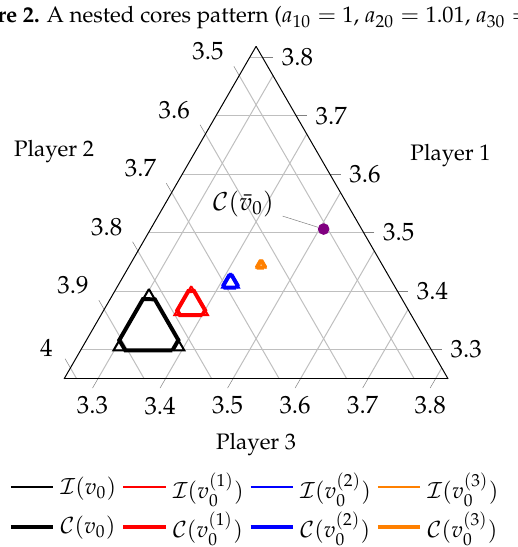
Figure 2. A nested cores pattern ( a 10 = 1, a 20 = 1.01, a 30 = 1).